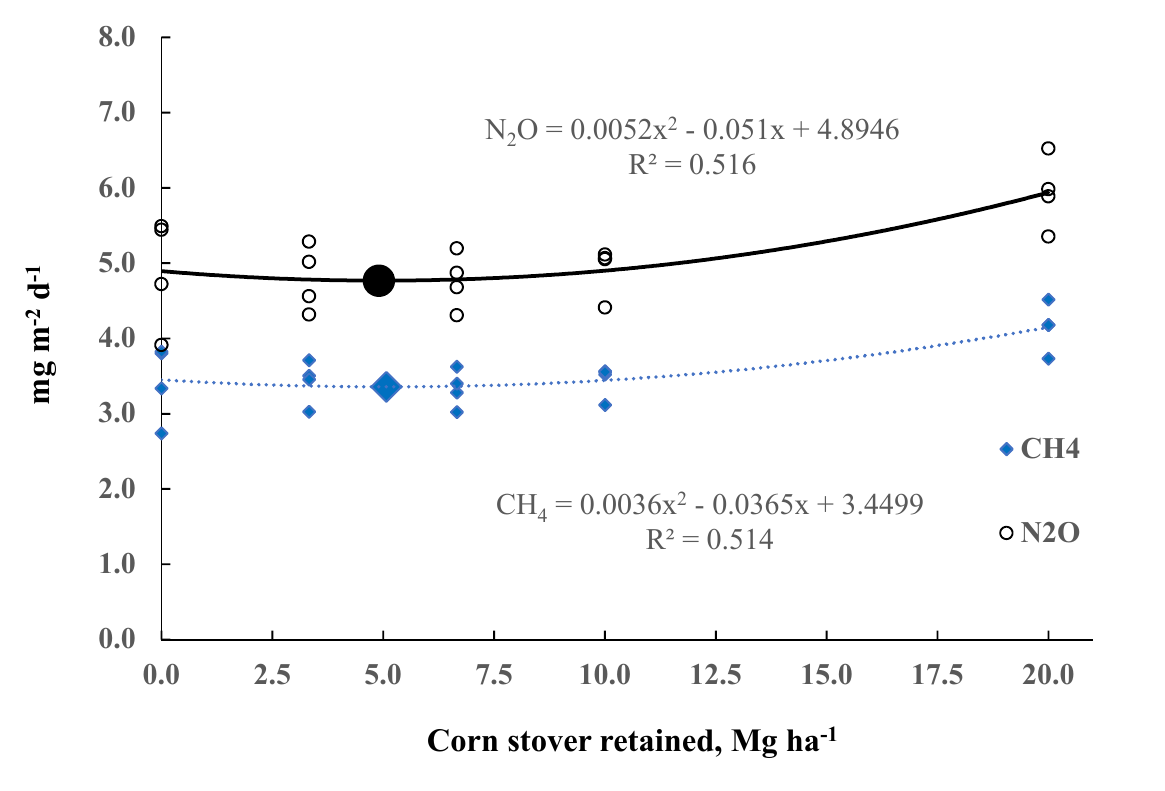
Figure 4. Flux of CH 4 and N 2 O (mg m − 2 day − 1 ) under five corn stover retained rates following corn planting in a continuous corn rotation in 2016 in Blacksburg, Virginia. Polynomial best fit line, quadratic equation and coefficient of determination (R 2 ) are presented for each gas. Minimum points ( x’ = − b/2a) and their associated gas response fluxes (mg m − 2 day − 1 ) were calculated for each significant quadratic function and are symbolized by an oversized solid shape (circle, N 2 O = [(0.0052 × 4.90 2 ) – (0.051 × 4.90) + 4.8946] = 4.76 mg m − 2 day − 1 ); diamond, CH 4 = [(0.0036 × 5.07 2 ) – (0.0365 × 5.07) + 3.4499] = 3.36 mg m − 2 day − 1